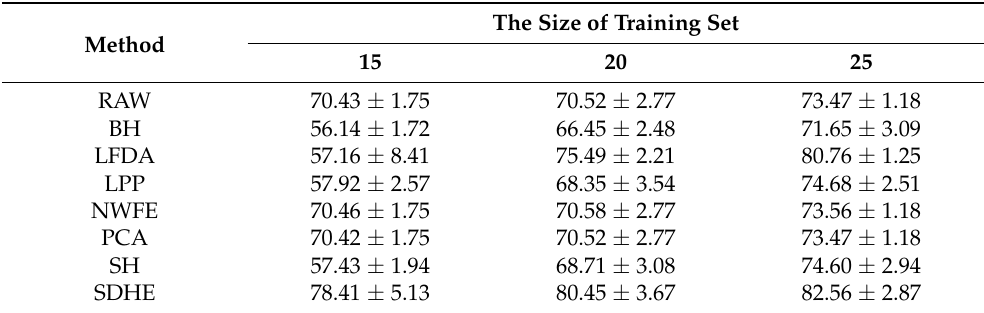
Table 7. Classification accuracy (%) at 30-dimensionality for the different sizes of training sets in Pavia University.